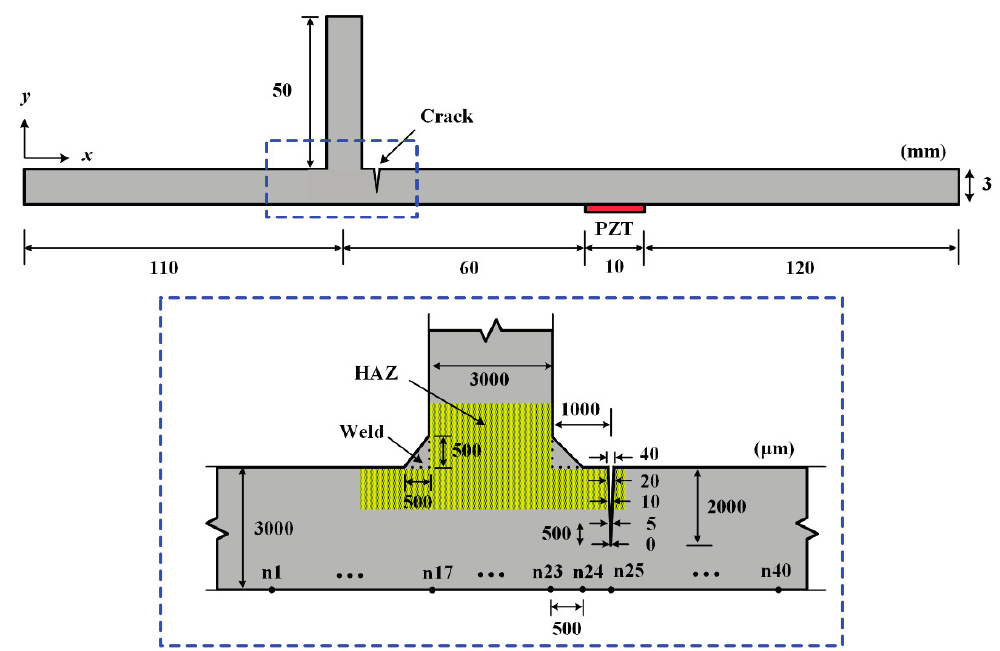
Figure 7. A 2D plane strain model with a vertical stiffener: PZT with a dimension of 10 × 0.508 mm 2 is modeled on the target surface for Lamb wave generation, and a crack with a depth of 2 mm and widths varying from 0 to 40 μ m is introduced at heat affected zone (HAZ). n indicates the inspection node number and 40 inspection nodes with an interval of 500 μ m across the